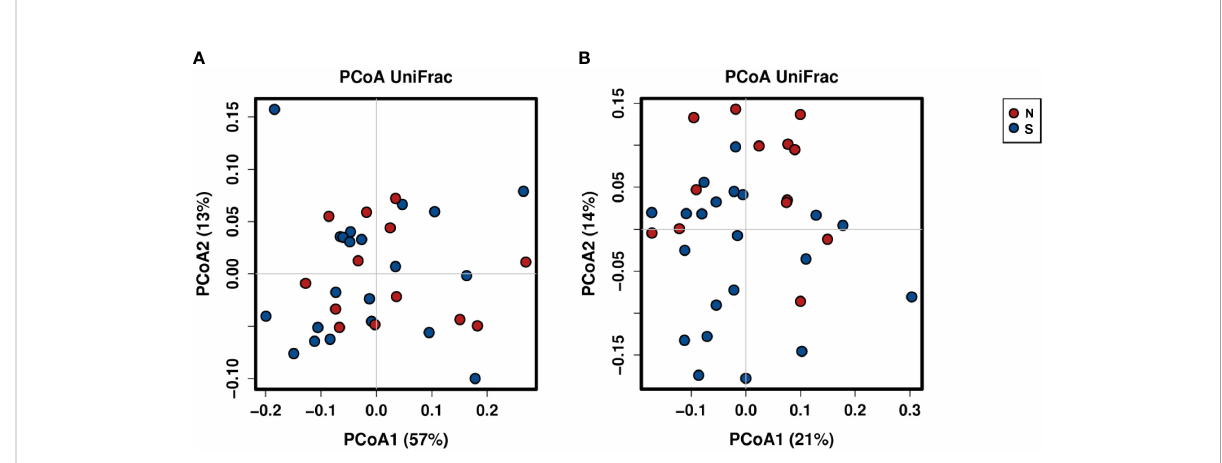
FIGURE 3 Principal coordinate analysis of the non-severe group and the severe group based on weighted (A) and unweighted (B) UniFrac distances. The plots are based on weighted (A) and unweighted (B) UniFrac distances and the relative abundances of bacterial OTUs. Red and blue plots indicate the non-severe and severe groups, respectively. N, non-severe group; S, severe group; PCoA, principal coordinate